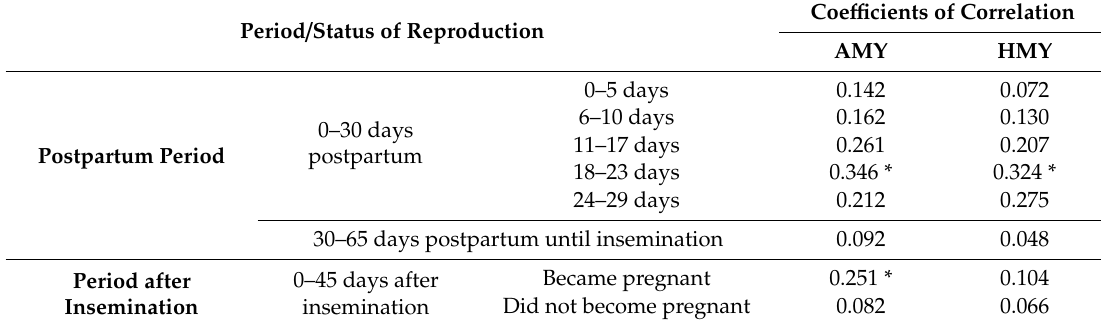
Table 3. Correlation of progesterone in milk with milk yield of cows (* p < 0.05—Pearson’s correlation is statistically significant) .